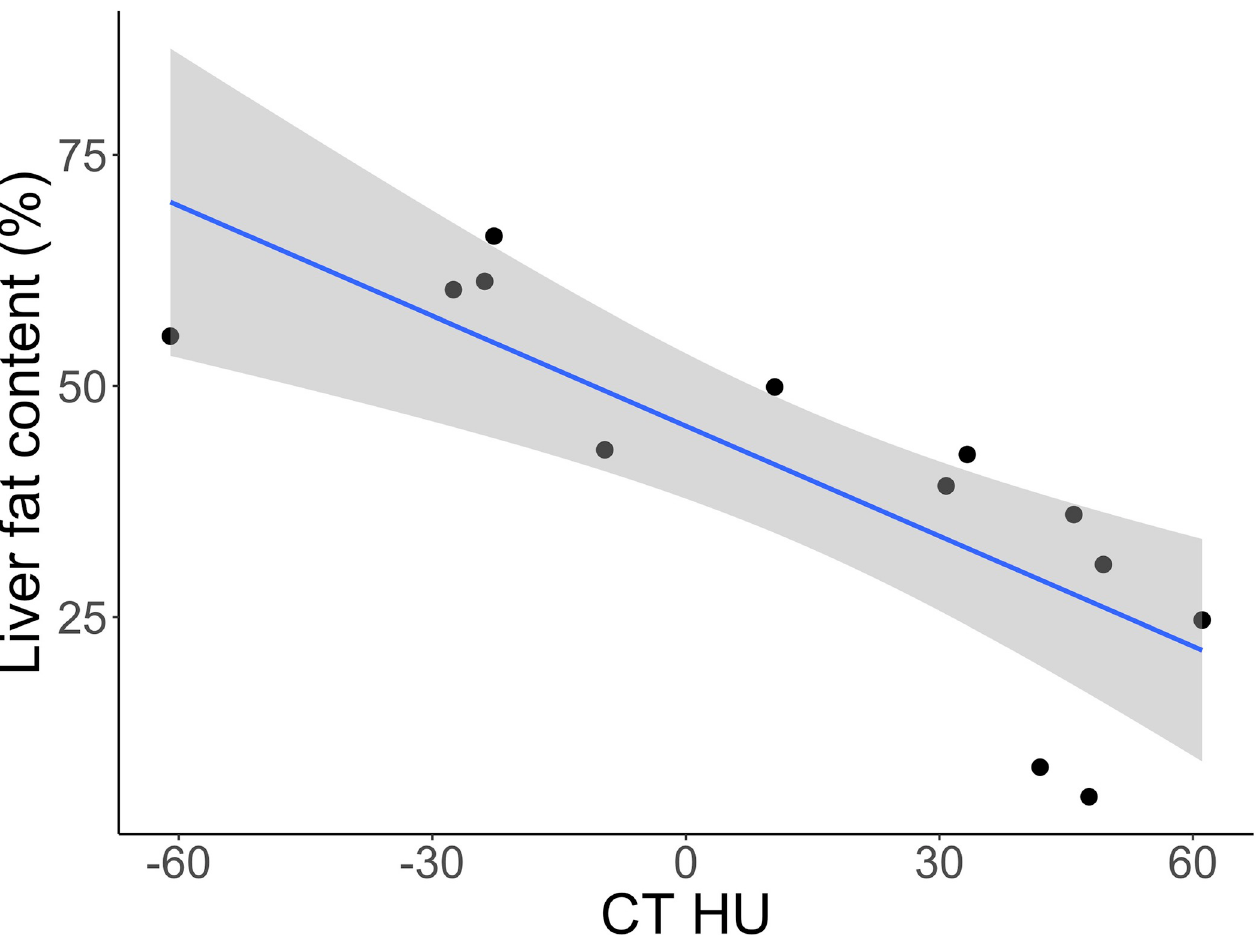
Fig 2. Box plot with superimposed dot plot of hepatic computed tomography hounsfield units (HU) across two simplified classes of hepatic lipid changes (no-lipid to mild and moderate to severe) based on an established grading system in bearded dragons [30] evaluated by a Mann-Whitney U test. The dotted red line represents a cut-off value of 21 HU to separate the classes of no-lipid to mild and moderate to severe as determined on receiver operating characteristic curve analysis.